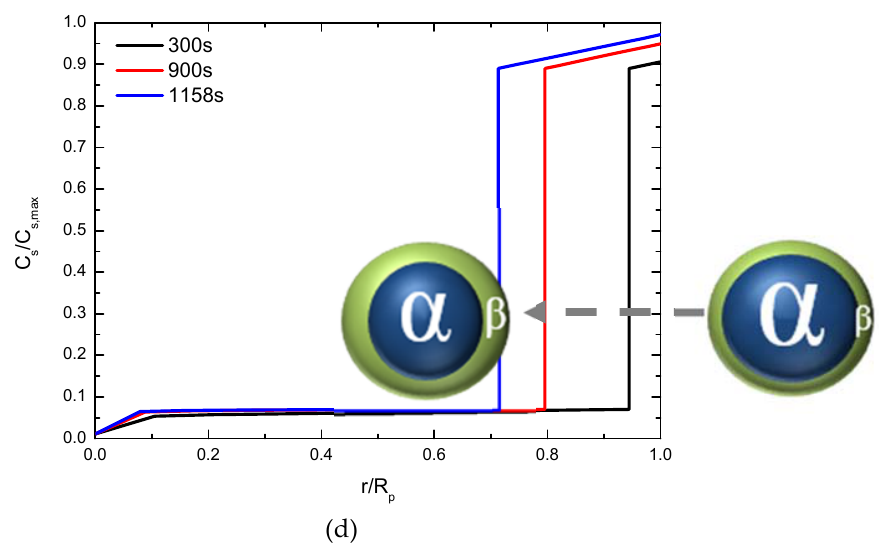
Figure 5. ( a ) Evolution of the two-phase interface between the α and β phases in LFP particles, and dimensionless lithium ion concentration profiles for ( b ) 0.5 C discharge, ( c ) 1 C discharge, and ( d ) 2 C discharge. The above simulation results were taken at the LFP particle located in the center of the electrode (x = 119 µ m, y = 0.5 cm, z = 0.5 cm).